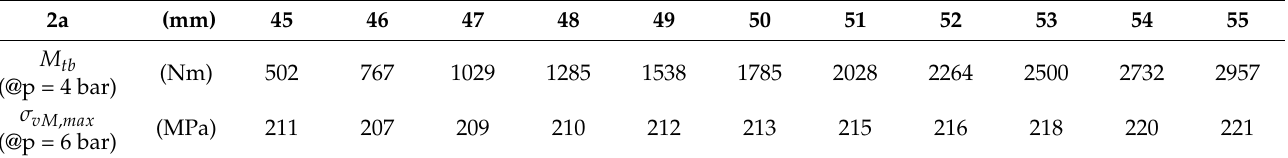
Table 5. Clamping torque and maximum stress for different values of 2a (t = 3 mm, g = 0.1